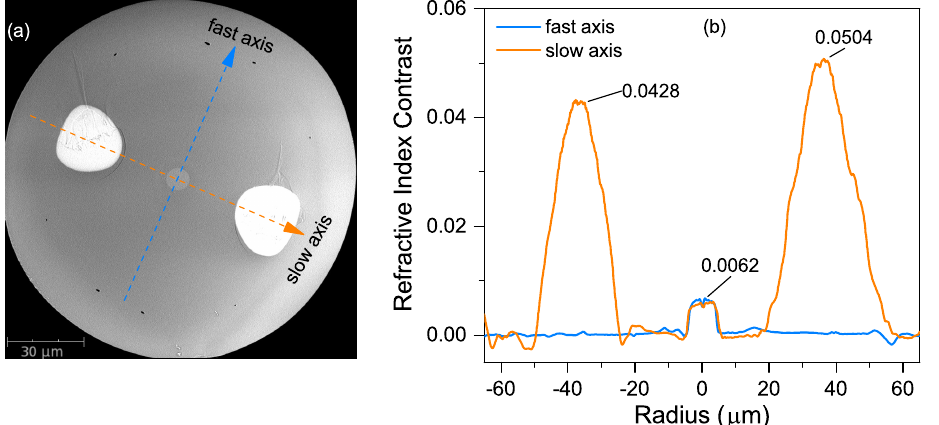
Figure 1. Scanning electronic microscopy picture ( a ) and corresponding refractive index profile ( b ) of the SiO 2 -Al 2 O 3 -La 2 O 3 (SAL) polarization-maintaining fiber (PMF).